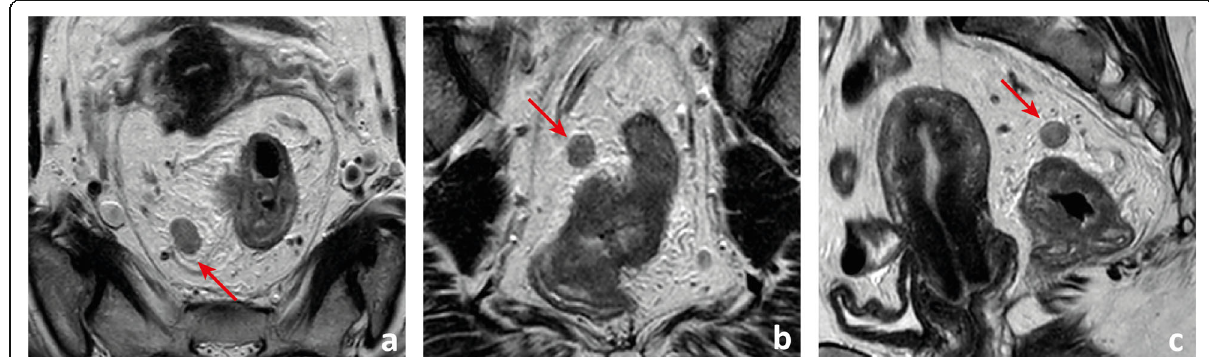
Fig. 10 Patient staged as mrT3a/b mrN2b due to multiple bulky lymph nodes in the mesorectum of which one is depicted, measuring 13 mm in the long axis and 10 mm in the short axis. The patient underwent surgery and was a pT3N0. While carefully reviewing the lymph node appearance on T2-WI, we notice they all presented with well-defined borders, homogeneous signal intensity and a preserved chemical